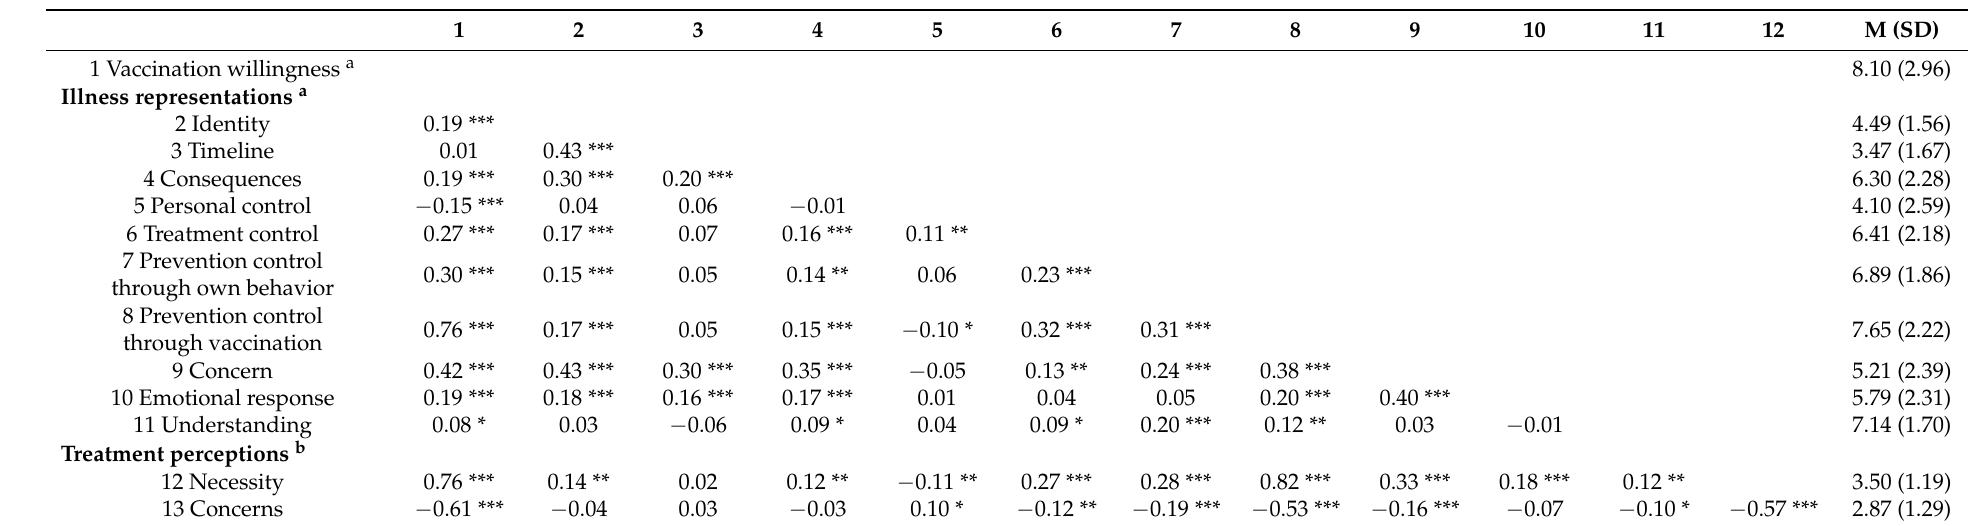
Table 2. Descriptives and bivariate correlations of the study